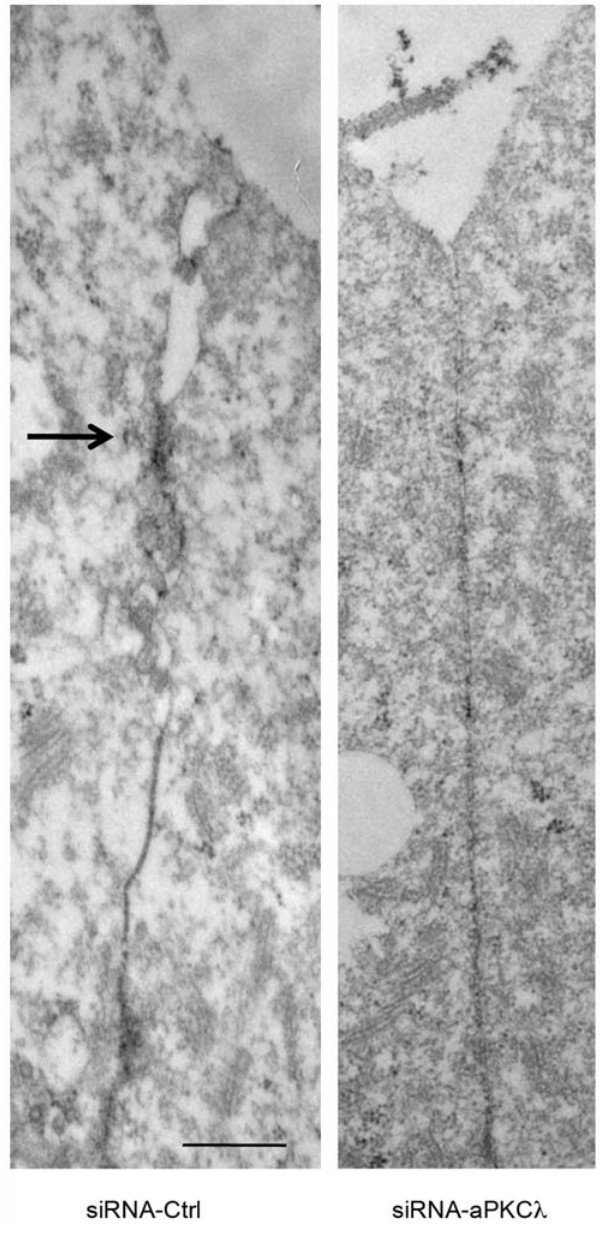
Figure 4. Tight junction formation is impaired in aPKC l - depleted embryos. Electron microscope analysis of 16-cell stage control siRNA (siRNA-Crtl) or siRNA-aPKC l injected embryos. Arrow points at tight junction. Scale bar: 0.5 m m.